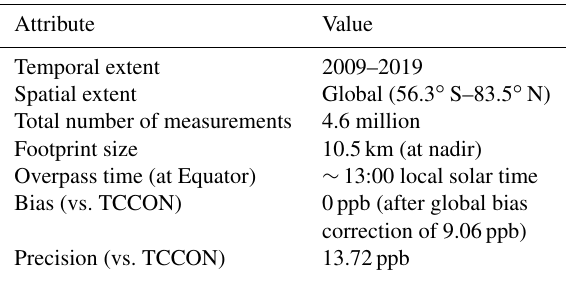
Table A1. Table summarising the key characteristics of the Univer- sity of Leicester GOSAT Proxy XCH 4